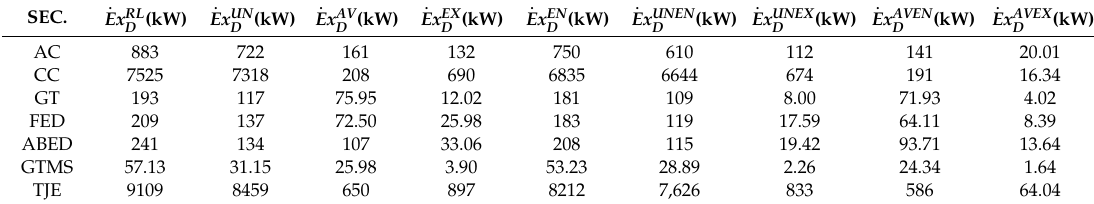
Table A3. Results for endogenous, exogenous, unavoidable and avoidable exergy demolition of the TJE and its sections for the MIL process mode for JP-8 utilization [63].